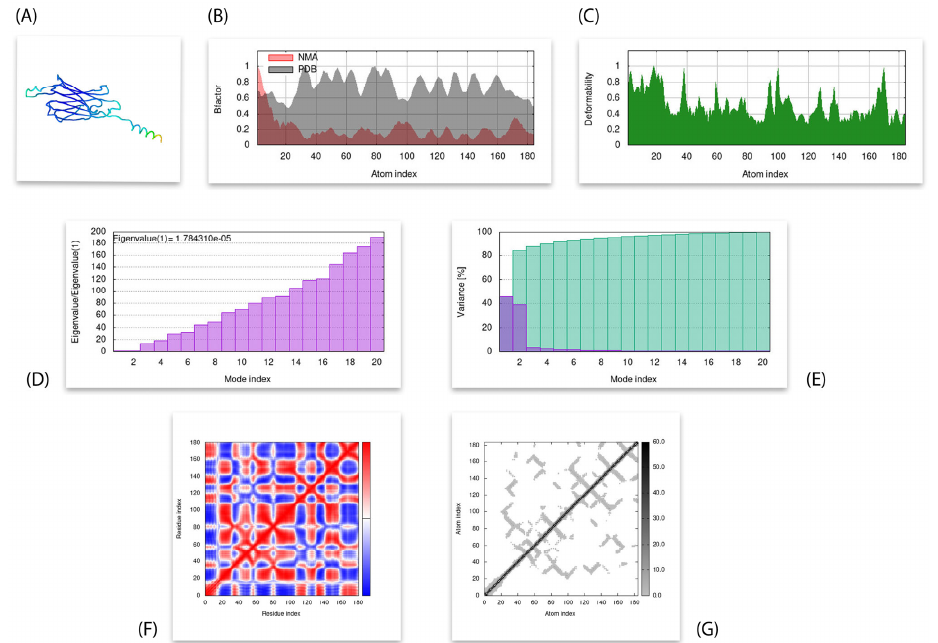
Figure 8. Results of molecular dynamic simulations through iMods. ( A ) Simulated 3D structure with MNA mobility; ( B ) Deformability; ( C ) B-factor; ( D ) Eigenvalues; ( E ) Variance (purple color indicates individual variances and green color indicates the cumulative variances; ( F ) Co-variance map (correlated (red) anti-correlated (blue) motions); and ( G ) Elastic network (darker grey region indicate stiffer regions).